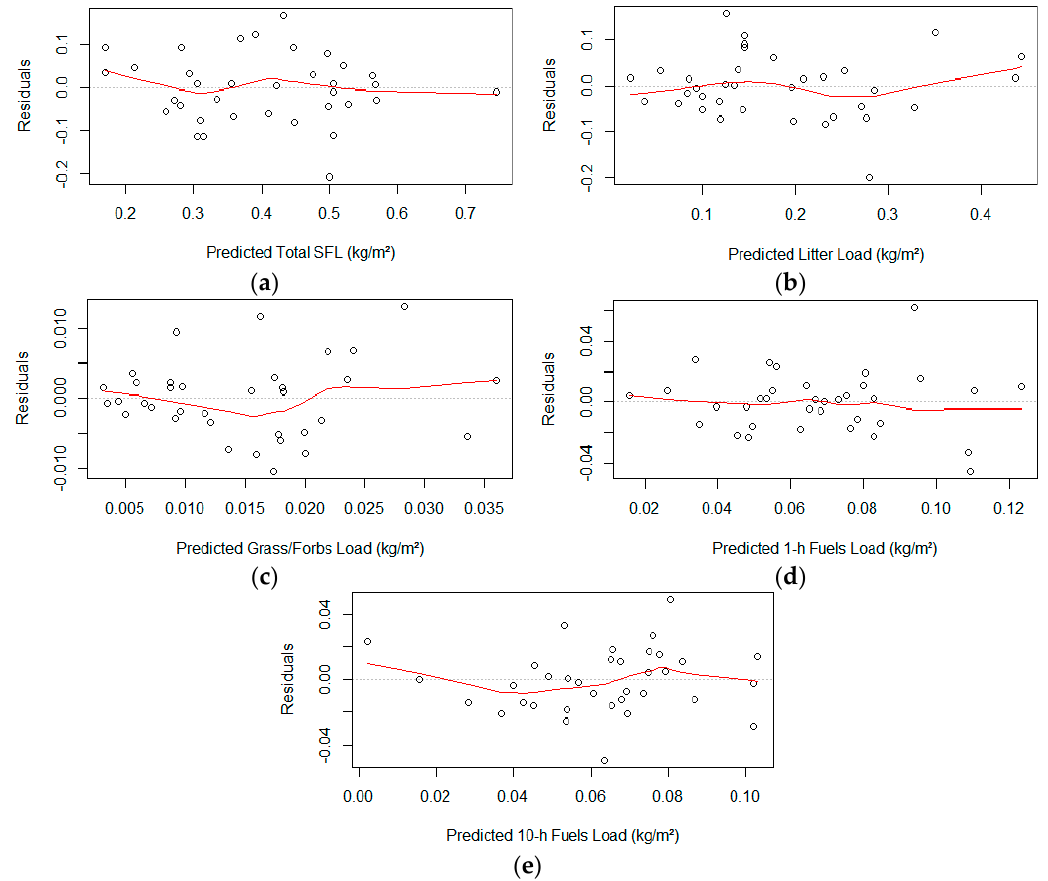
Figure 5. The residuals in the load prediction of the ( a ) total surface fuels, ( b ) litter, ( c ) grass/forbs, ( d ) 1-h, and ( e ) 10-h fuels through the Simulated Annealing (SA) variable selection method and multiple linear regression analysis. The red lines represent the loess smoothing curves. These results refer to the models produced with the use of both LiDAR-derived structural and intensity metrics.